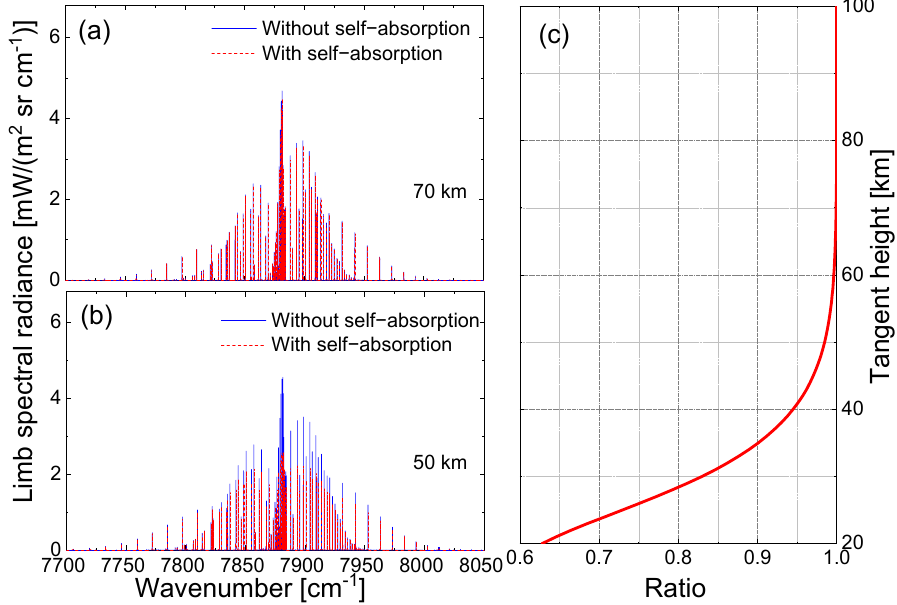
Figure 5. ( a ) The simulated limb spectral brightness of the O 2 (a 1 ∆ g ) band at a tangent height of 70 km (with and without the effect of self-absorption); ( b ) the simulated limb spectral brightness of the O 2 (a 1 ∆ g ) band at a tangent height of 50 km (with and without the effect of self-absorption); ( c ) the ratio of spectral line brightness with and without considering the self-absorption effect.